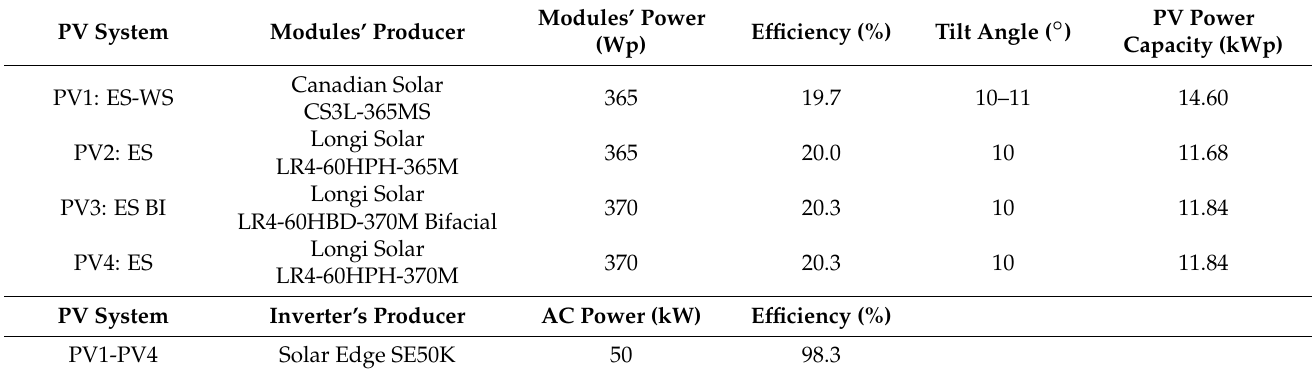
Table 1. Main electrical parameters of the photovoltaic (PV) modules used in PV1–PV4 installations and system orientation details.